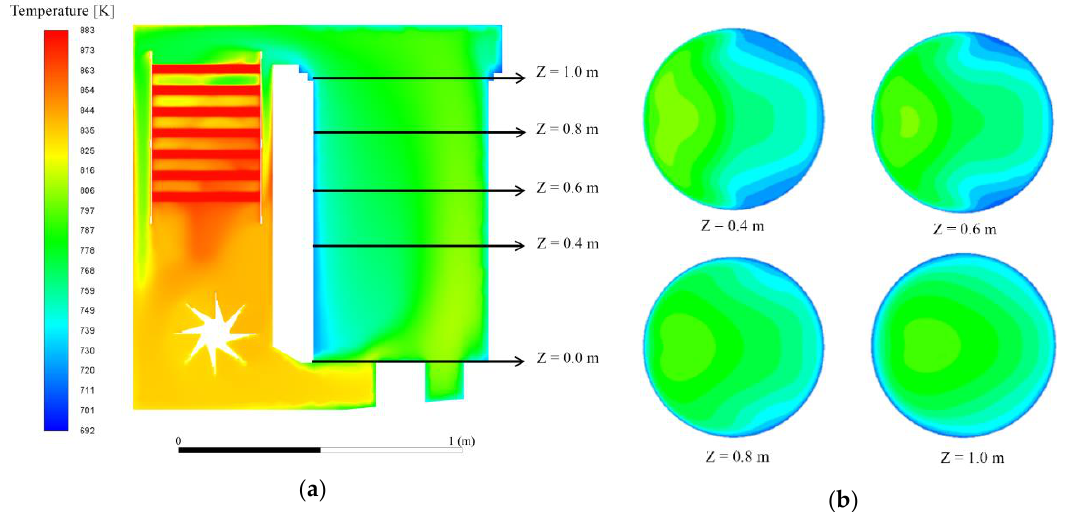
Figure 8. Temperature distribution of the baseline operation without the charging basket. ( a ) Cut view of the symmetry plane; ( b ) cut views at different heights.